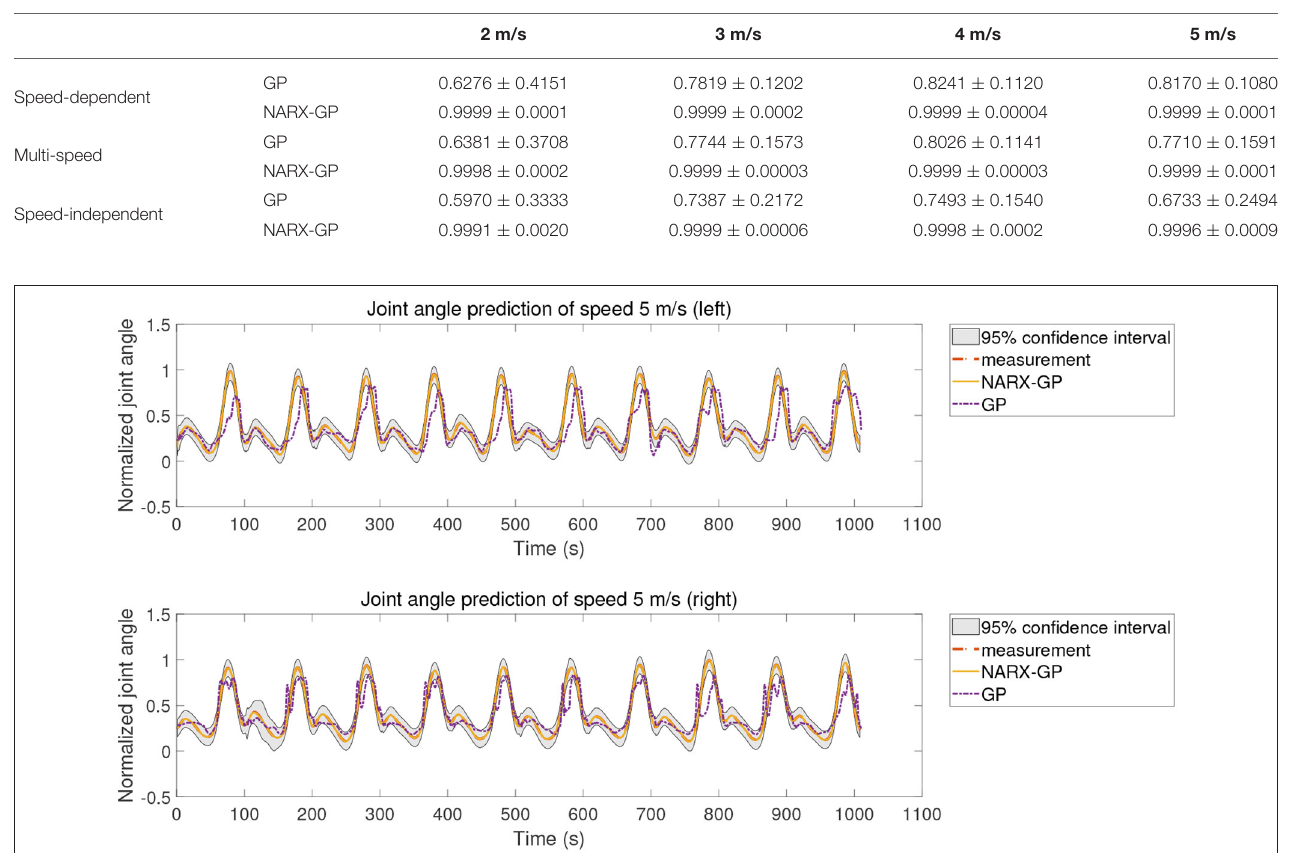
TABLE 2 | CC between the predicted joint angle of different models and the measurements (“true” values) of all subjects (mean ± std).